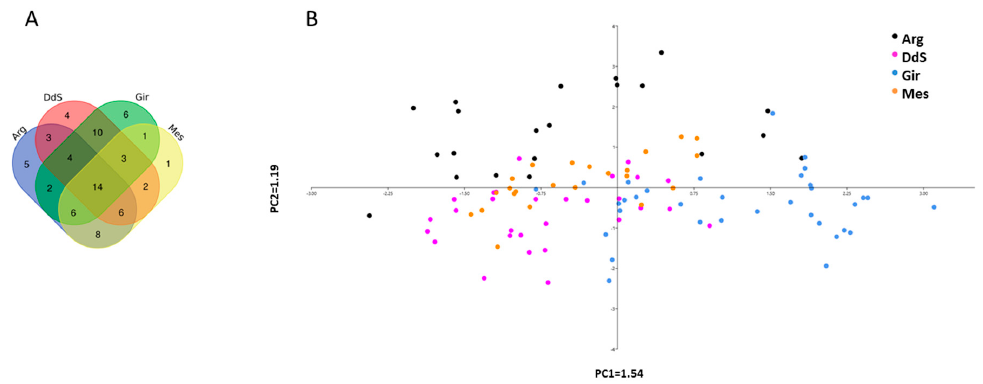
Figure 3. ( A ) Venn diagram of shared and proper CNVRs of each breed. ( B ) Principal Component Analysis obtained using the CNVR matrix 0, 1, 2 (0 = normal state; 1 = deletion; 2 = duplication). Arg = Argentata; DdS = Derivata di Siria; Gir = Girgentana; Mes =